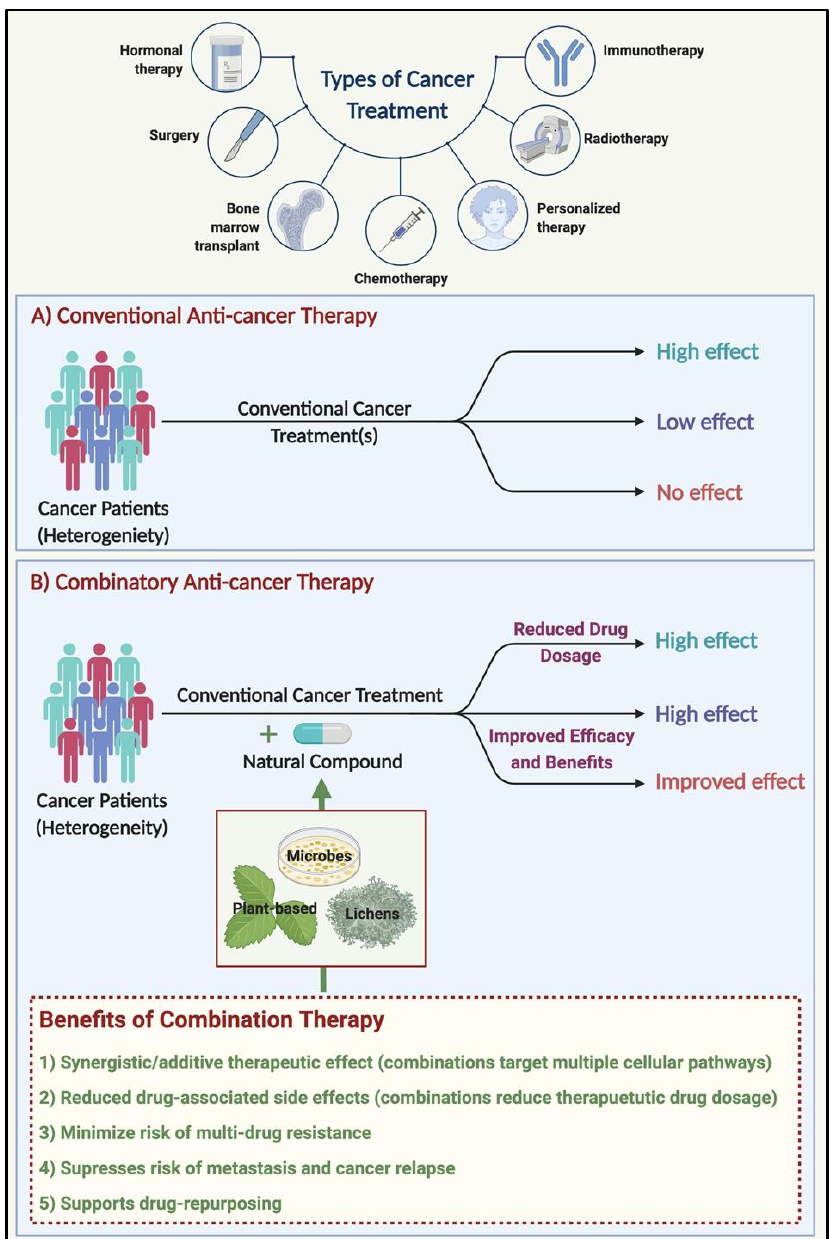
Figure 2. Benefits of combination therapy (using natural compounds in anti-cancer treatment). The conventional cancer treatments include surgical removal of the tumor, chemotherapy, and radiation therapy, in addition to the standard therapeutic procedures, depending on the type/sub-type of cancer. In a heterogeneous population of cancer patients, while conventional/standard treatment practices benefit some patients, in others, the treatment strategy may have little to no effect. In such a scenario, using a natural compound in combination with the conventional/standard treatment procedures may prove to be beneficial in several ways. Created with BioRender.com.